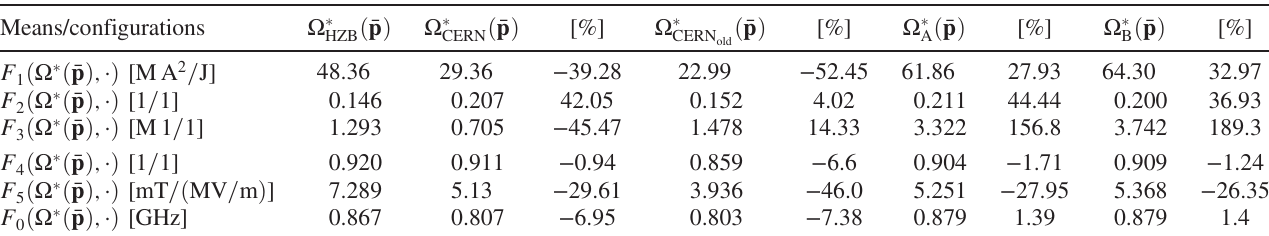
TABLE VI. Results of the MO optimization for the second mode — objective space a . Means/configurations